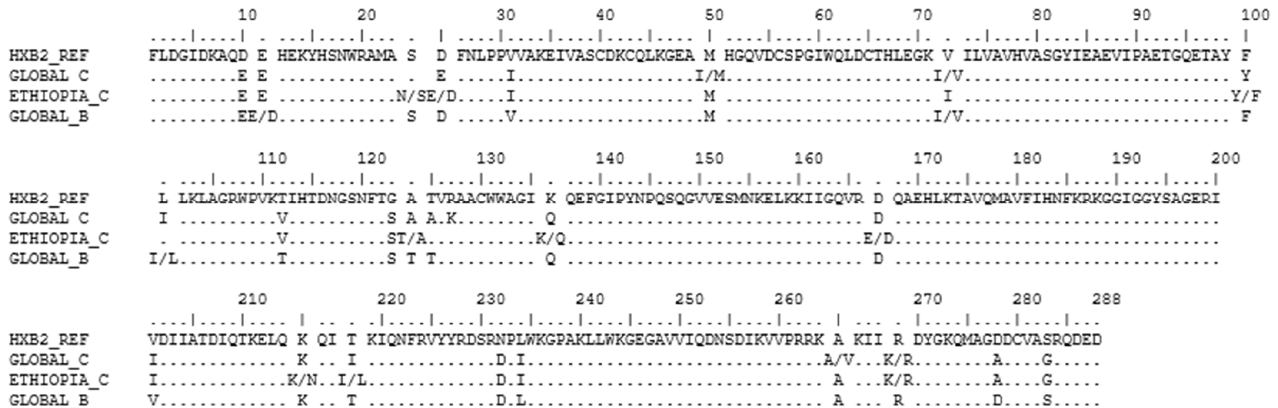
Figure 6. Alignment of integrase (IN) consensus sequence from LANL database (https://www.hiv.lanl.gov (accessed on 25 July 2021)). The consensus sequence from the global HIV-1 subtype C ( n = 1410 sequences) is represented as GLOBAL C, the global HIV-1 subtype B ( n = 1884 sequences) is represented as GLOBAL_B, and the Ethiopian subtype C sequence ( n = 453 sequences) is represented as ETHIOPIA_C. Positions with more than one amino acid are both represented. HXB2 represents the consensus HIV-1 subtype B reference sequence from the LANL database (accession number: K03455).